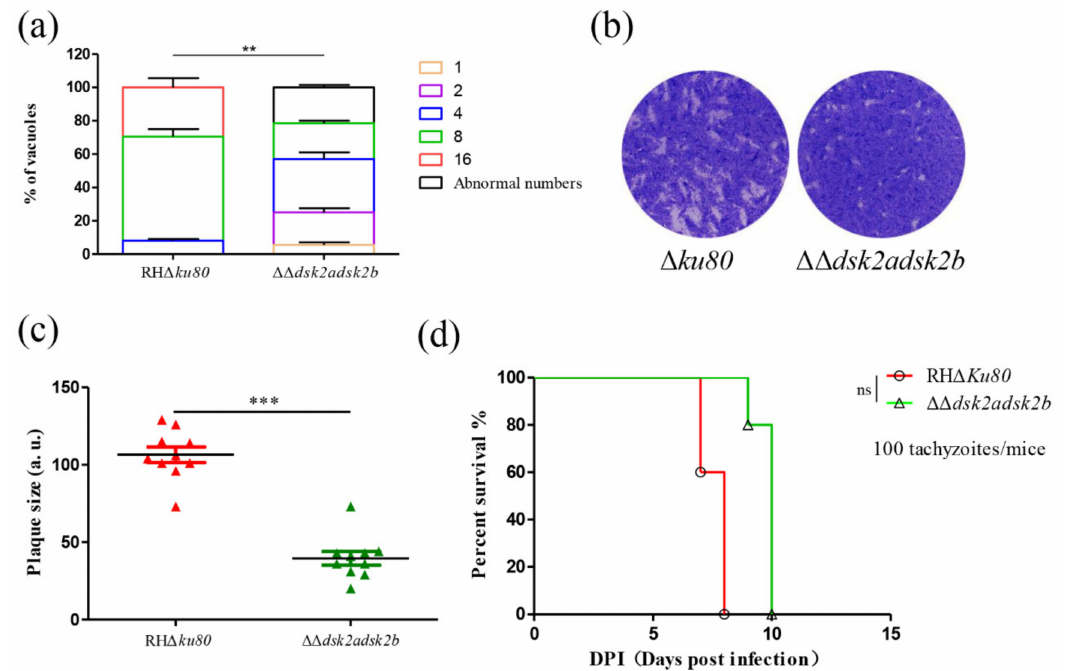
Figure 6. Deletion of DSK2s inhibits T. gondii growth. ( a ) Replication assay of the ∆∆ dsk2adsk2b and ∆ ku80 strains. IFA was performed after growth in HFF cells for 24 h. Anti-GAP45 antibody was used to stain parasites. Tachyzoites were counted in 100 PVs. Data represents means ± SEM for two independent experiments. ** p < 0.01. ( b , c ) Plaque formation of ∆∆ dsk2adsk2b and ∆ ku80 strains. A total of 500 tachyzoites were inoculated in HFFs for 7 days and then stained with crystal violet ( b ). Quantification of plaque sizes ( c ). 10 plaques were quantified. *** p < 0.001. ( d ) Survival curve of BALB/c mice intraperitoneally injected with 100 tachyzoites of ∆∆ dsk2adsk2b or ∆ ku80 strain for 10 days. ns: not